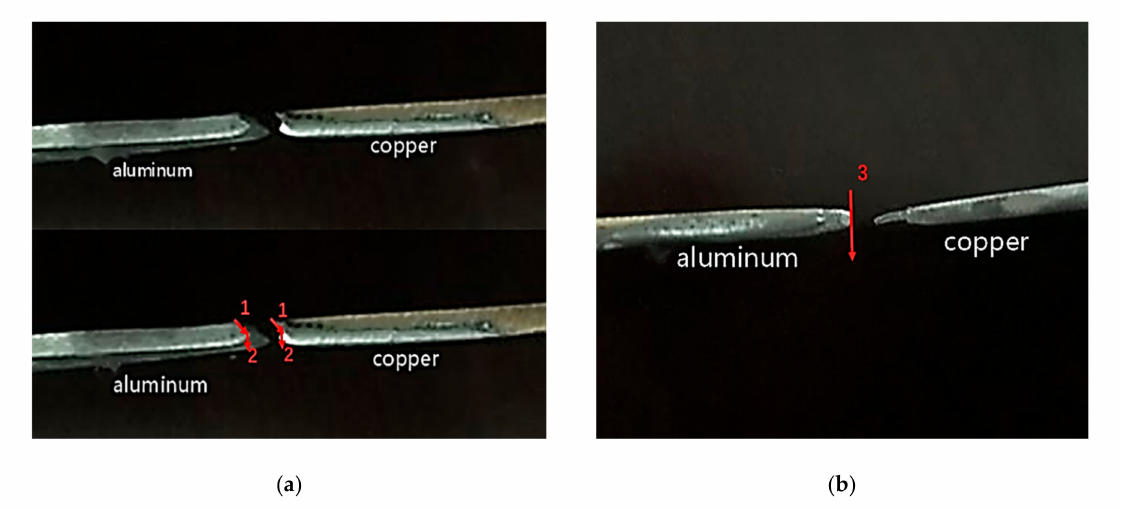
Figure 10. Macro morphology under di ff erent fracture modes. ( a ) Macro-morphology of mode I fracture. ( b ) Macro-morphology of mode II fracture.